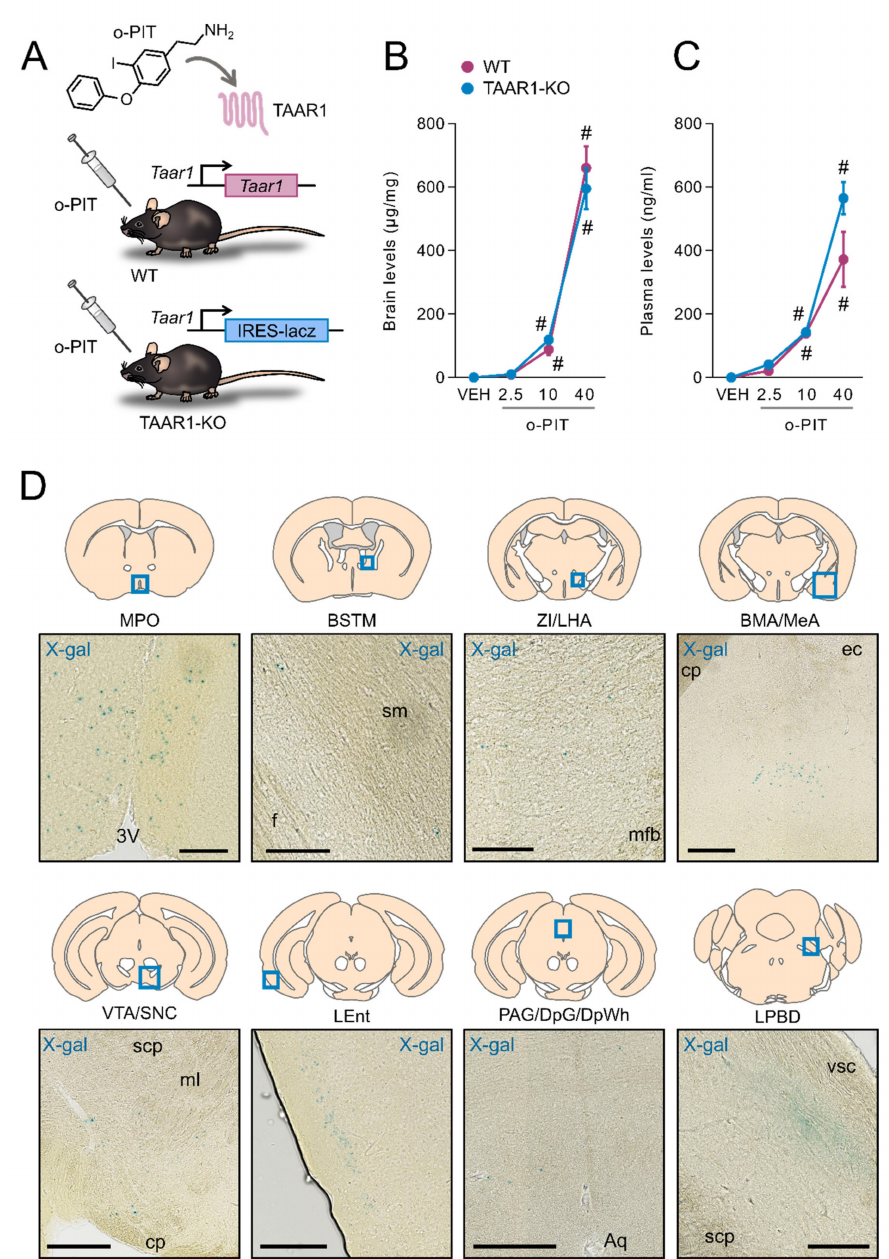
Figure 1. O-PIT brain and plasma pharmacokinetics in TAAR1-KO mice and TAAR1 distribution in the brain. ( A ) Chemical structure of o-PIT and schematic representation of the TAAR1-KO mouse genetic construct. ( B – C ) Levels of o-PIT were quantified in brain ( B ) and plasma ( C ) 60 min after administration. Levels are expressed as absolute values per weight of brain sample ( µ g/mg) and volume of plasma (ng/mL). All data are means ± SEM. N = 4–5 per group. p < 0.05, influence of treatment (#) or genotype (*). VEH: vehicle. ( D ) Neuroanatomical distribution of TAAR1 expressing cells using β -galactosidase detection in TAAR1-KO mice sections and that the staining represents expression under the endogenous TAAR1 promoter (N = 3). MPO: medial preoptic nucleus (scale bar: 100 µ m), BSTM: medial bed nucleus of stria terminalis (scale bar: 100 µ m), ZI/LHA: zona incerta/lateral hypothalamic area (scale bar: 100 µ m), BM/Me: basomedial/medial amygdaloid nucleus (scale bar: 250 µ m), VTA/SNC: ventral tegmental area/compact part of substantia nigra (scale bar: 250 µ m), LEnt: lateral entorhinal cortex (scale bar: 250 µ m), PAG/DpG/DpWh: periaqueductal grey/deep grey layer of superior colliculus/deep white layer of superior colliculus (scale bar: 250 µ m), LPBD: dorsal part of lateral parabrachial nucleus (scale bar: 100 µ m), 3V: 3rd ventricle, sm: stria medullaris, f: fornix, mfb: medial forebrain bundle, cp: cerebral peduncle, ec: external capsule, scp: superior cerebellar peduncle, ml: medial lemniscus, Aq: